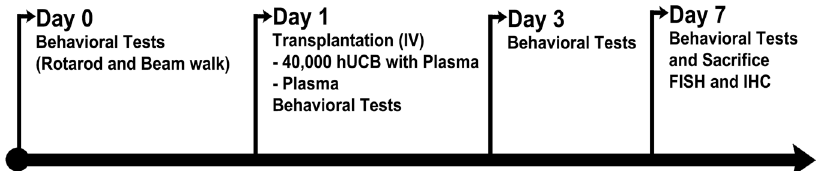
Fig. 6 Treatment timeline. Behavioral tests at baseline were performed on Day 0 prior to transplantation. On Day 1, intravenous transplantation with P or hUCB + P was performed. Behavioral tests were conducted again on day 1, 3, and 7 post transplantation. Animals were sacri fi ced on day 7 for brain and gut for fl uorescent in ‐ situ hybridization (FISH) and immunohistochemistry to assess PD